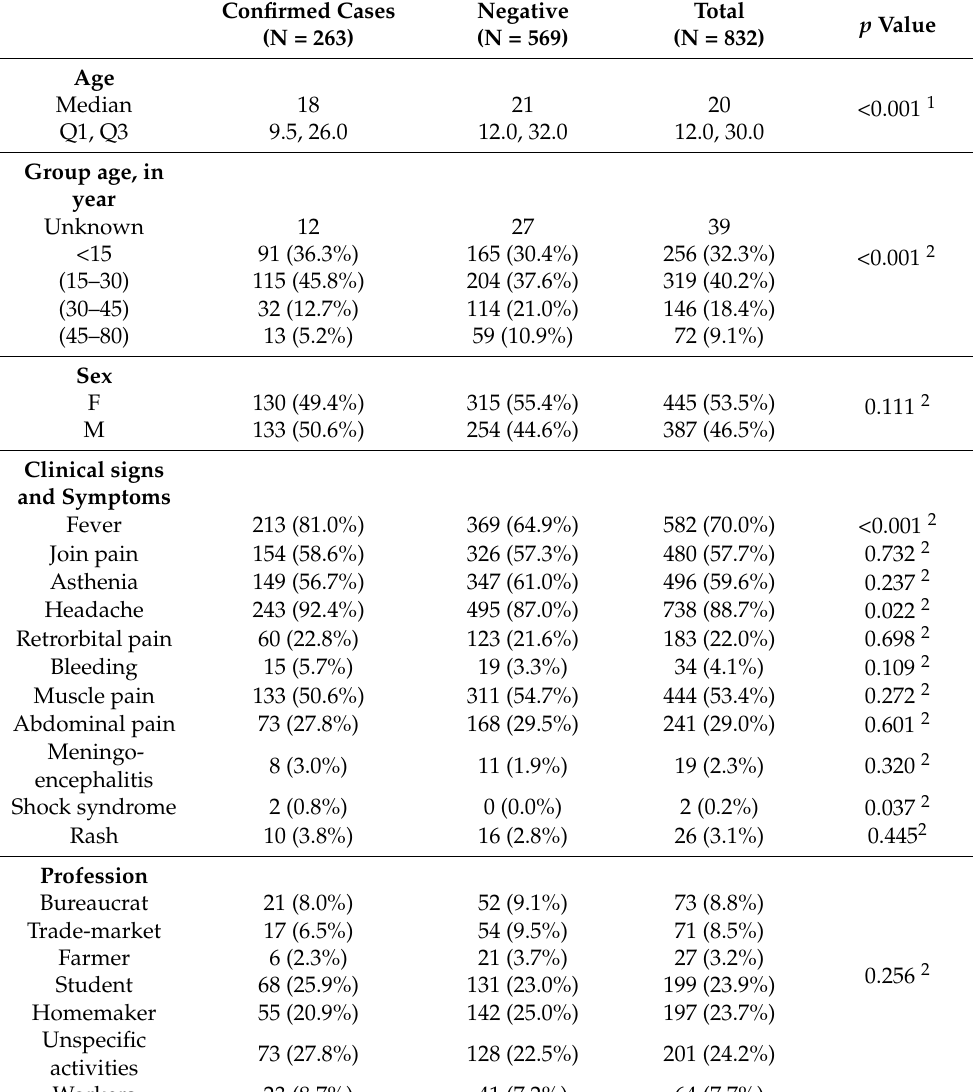
Table 1. Epidemiologic and clinical characteristics of suspected and confirmed dengue cases, Touba, Senegal,